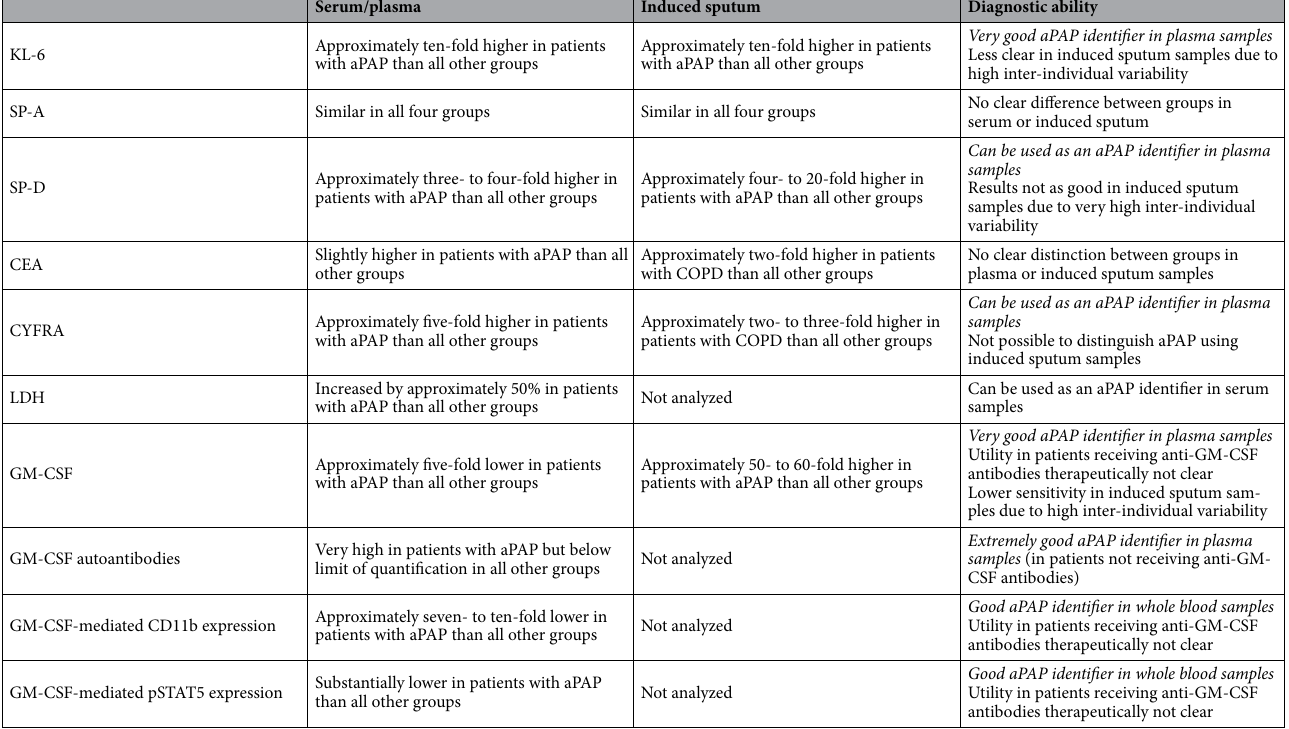
Table 5. Summary of aPAP diagnostic ability for pre-specified biomarkers. aPAP autoimmune pulmonary alveolar proteinosis, CD11b cluster of differentiation molecule 11b, CEA carcinoembryonic antigen, COPD chronic obstructive pulmonary disease, CYFRA cytokeratin-fragment, GM-CSF granulocyte– macrophage colony-stimulating factor, KL-6 Krebs von den Lungen 6, LDH lactate dehydrogenase,